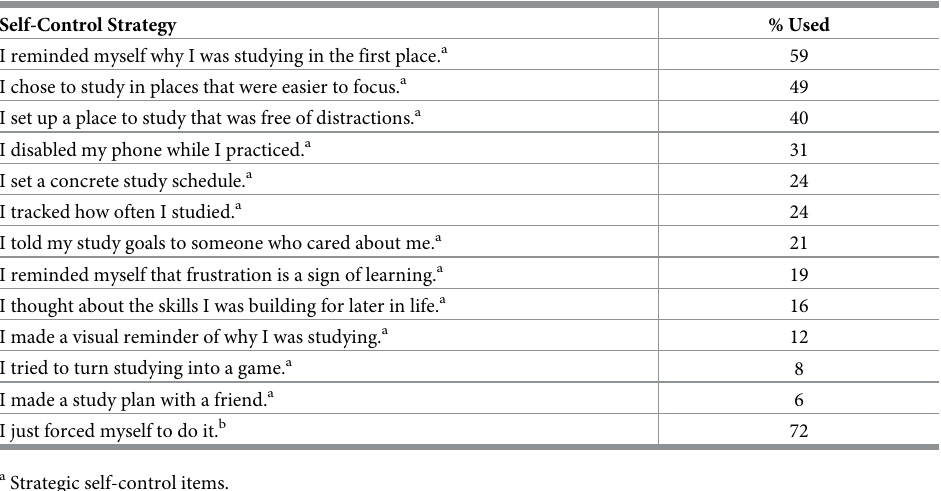
Table 1. Study 1 individual self-control approaches. Self-Control